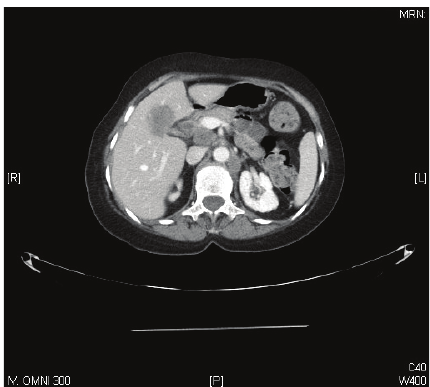
Figure 2: Postchemotherapy abdominal CT showing interval regression of the known masses around the GB, portocaval, aorto- caval, and left paraaortic stations by about